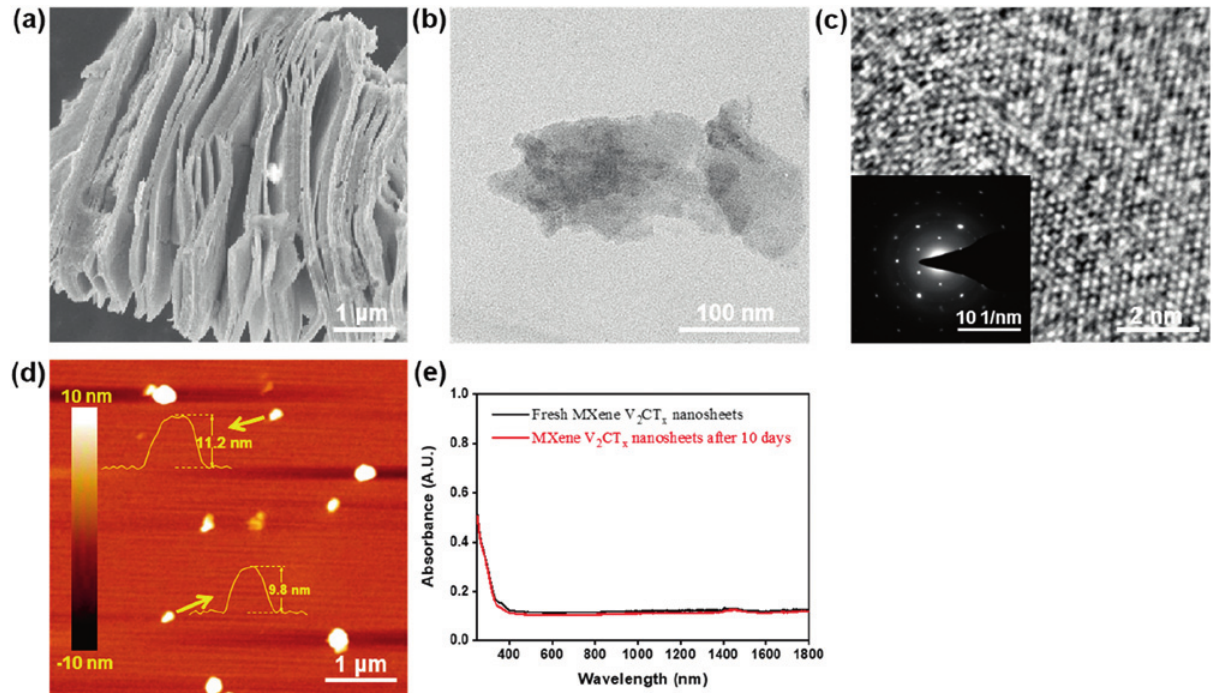
Figure 1: Structural characterization of as-synthesized V 2 CT x nanosheets. (a) SEM image of V 2 C after selective removal of Al. (b) TEM image of exfoliated V 2 CT x nanosheets. (c) HRTEM of exfoliated V 2 CT x nanosheets. (d) AFM image of exfoliated V 2 CT x nanosheets. (e) UV – Vis – NIR spectroscopy of exfoliated V 2 CT x nanosheets before and after 10